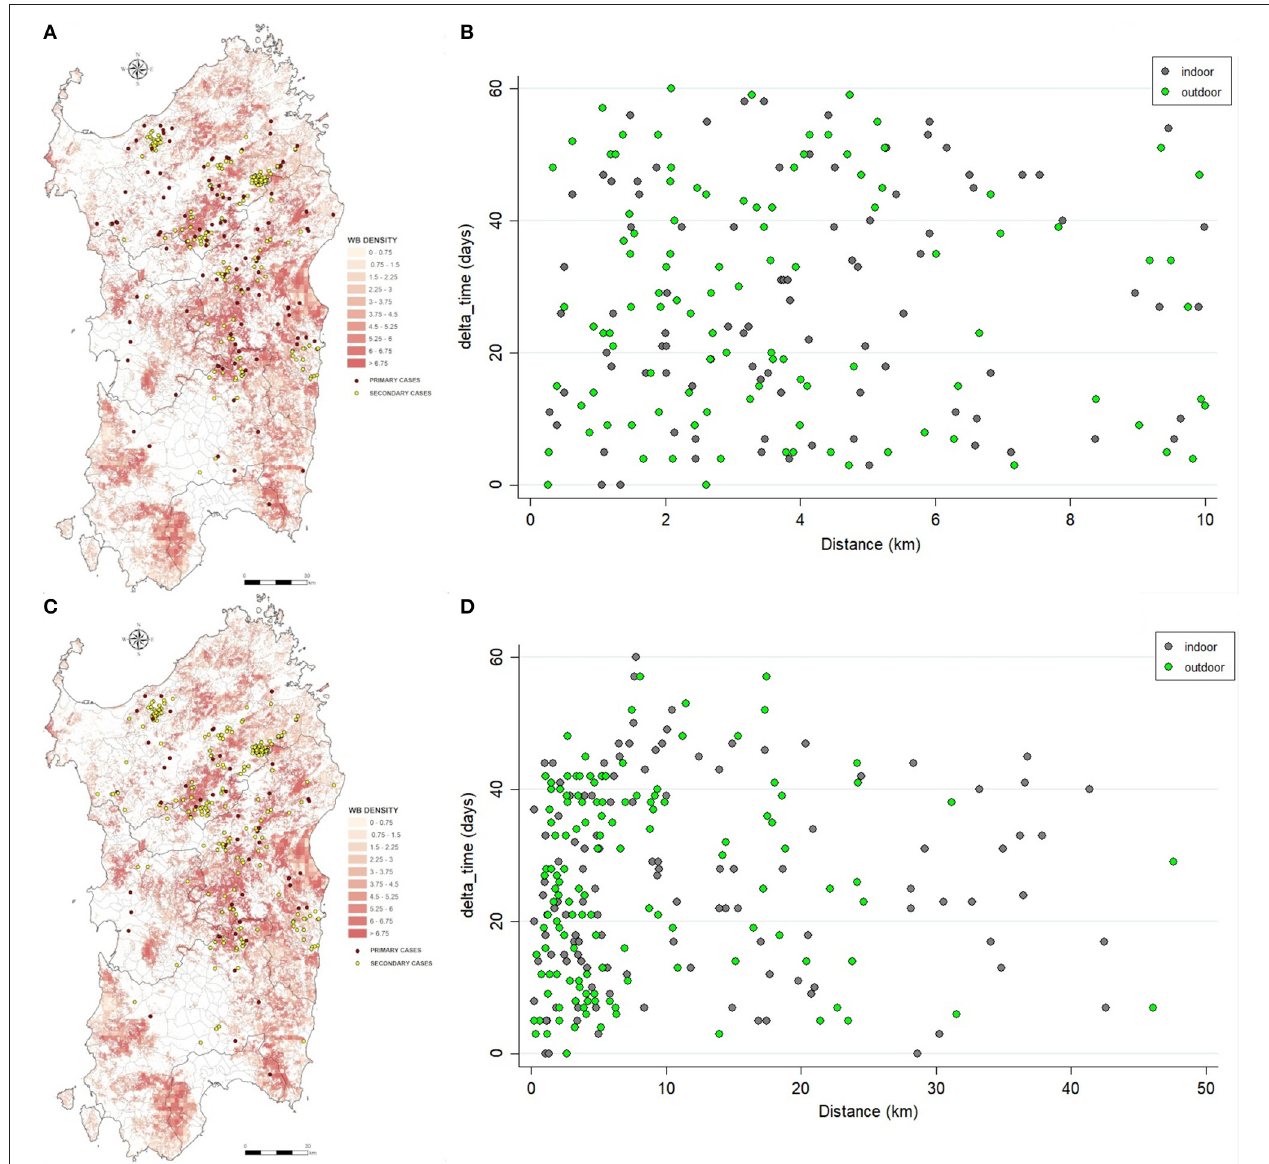
FIGURE 5 | Spatial distribution of the primary (red) and secondary cases (yellow) detected by nearest-neighbor (A) or uniform-smoothed kernel functions (C) . Scatterplots shown the relation between difference time and distance between the secondary outbreak and its primary outbreak, by nearest-neighbor (B) or uniform-smoothed kernel functions (D)